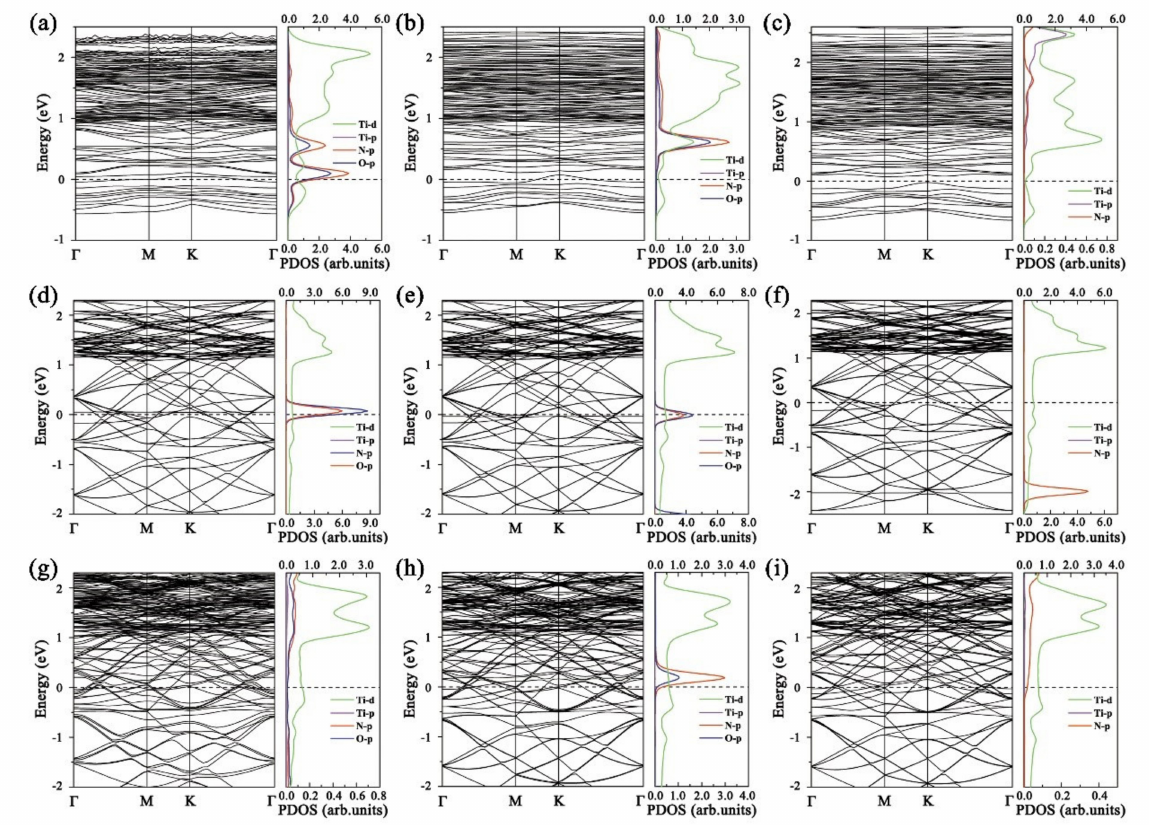
Figure 6. Band structures and PDOS of Ti 2 NO 2 after adsorbing ( a ) NO, ( b ) NO 2 , and ( c ) NH 3 ; Ti 2 NF 2 after adsorbing ( d ) NO, ( e ) NO 2 , and ( f ) NH 3 ; Ti 2 N(OH) 2 after adsorbing ( g ) NO, ( h ) NO 2 , and ( i ) NH 3 (Ti d -orbital uses top abscissa and other orbitals use bottom coordinate).